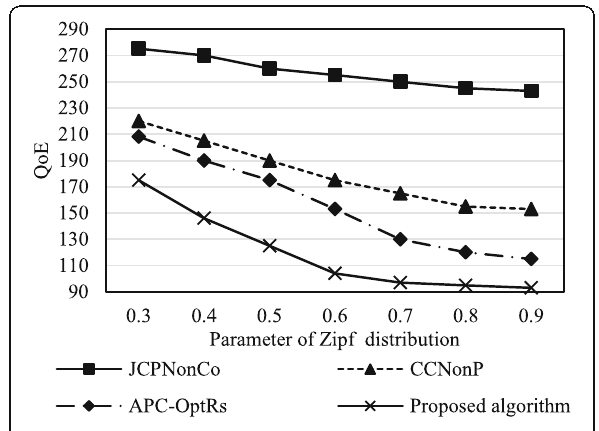
Fig. 10 QoE function changes with Zipf parameter Fig. 11 Average access delay of users